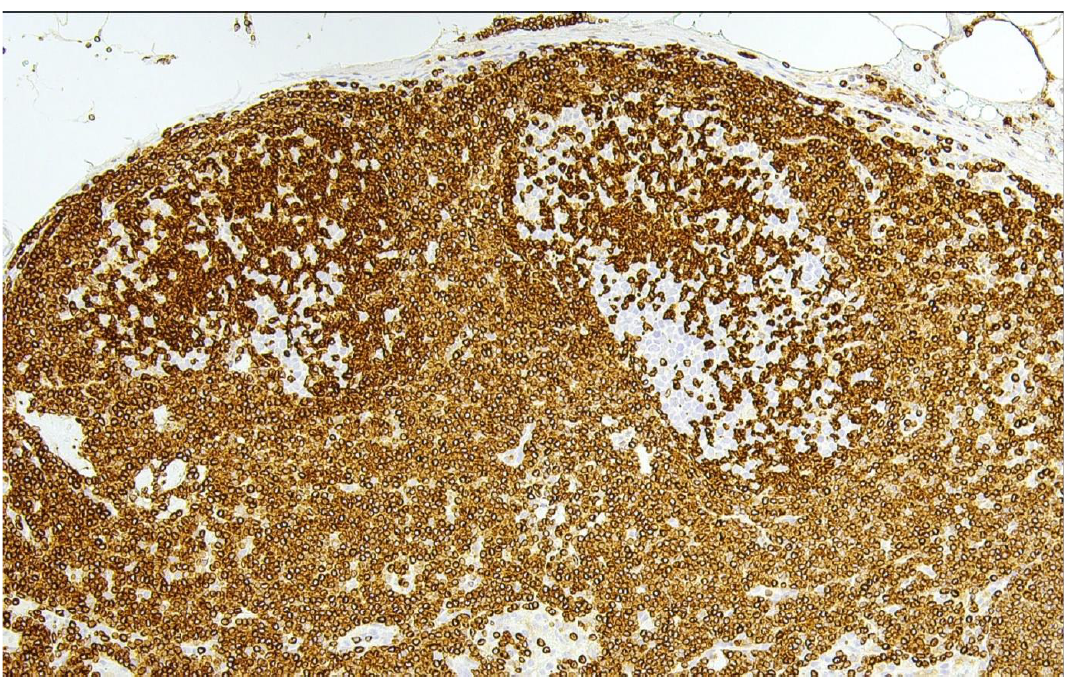
Figure 1. In-situ follicular B-cell neoplasm (H&E ×100). This photomicrograph illustrates strong aberrant reactivity for BCL2 in two germinal centers showing a slightly stronger staining than the surrounding marginal zone B- and T-cells. The overall nodal architecture is well preserved.